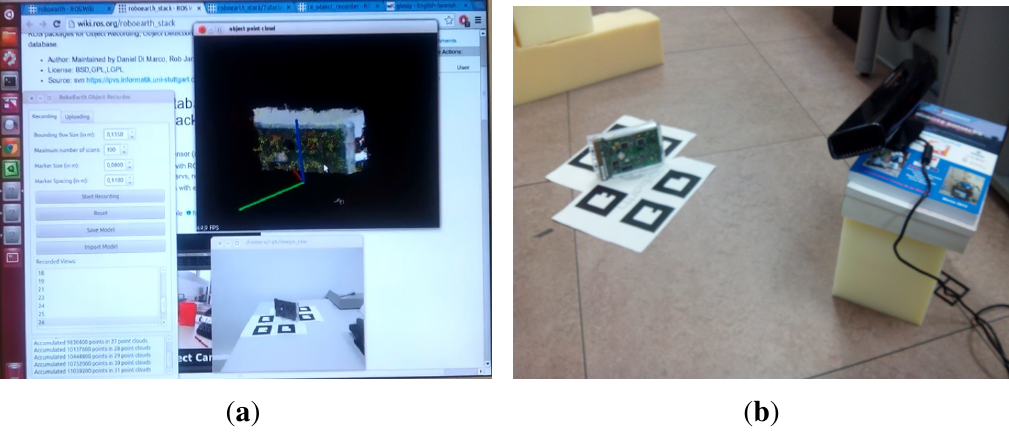
Figure 26. ( a ) Hard drive model; and ( b ) Hard drive